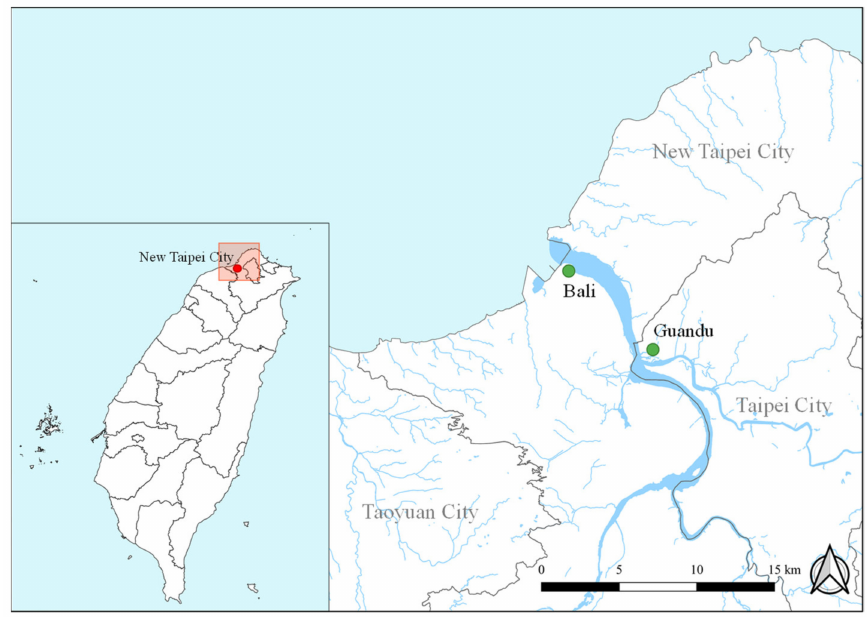
Figure 1. Two mangrove forest sites in Taiwan were sampled in the present